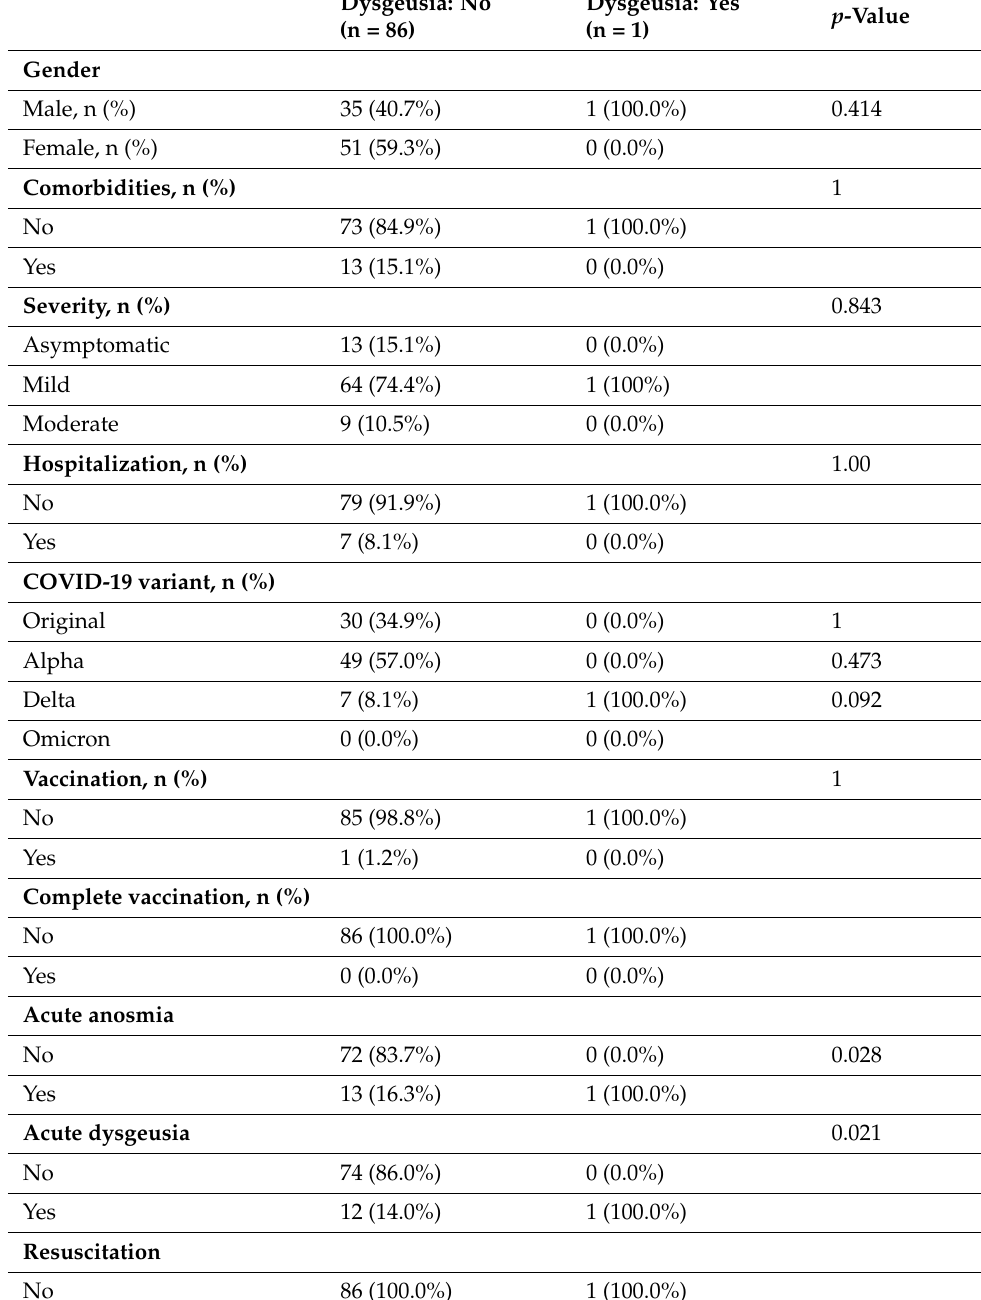
Table 10. Dysgeusia at FUP